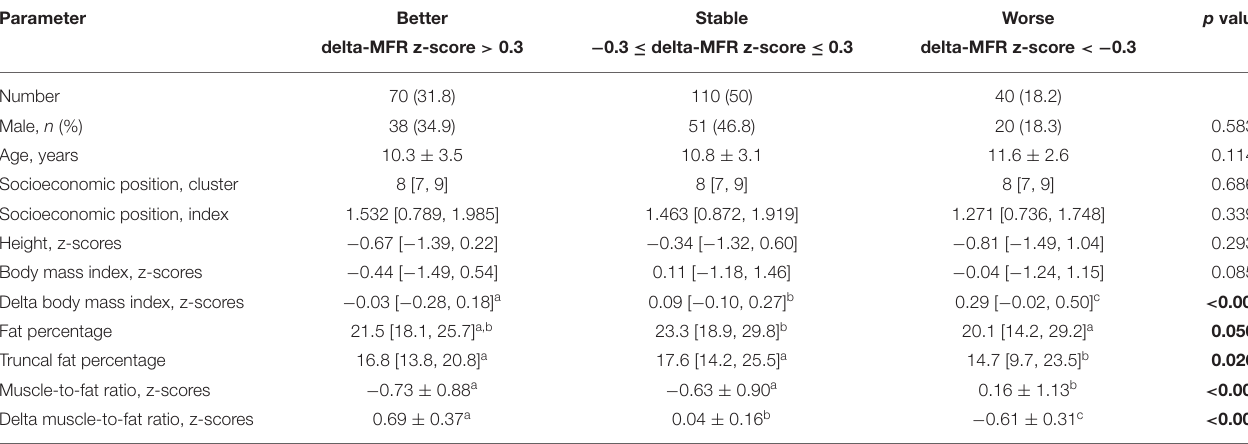
TABLE 3 | Sociodemographic, anthropometric, and body composition parameters of the study cohort before COVID-19 pandemic stratified by change in muscle-to-fat ratio (MFR) z-scores. Parameter